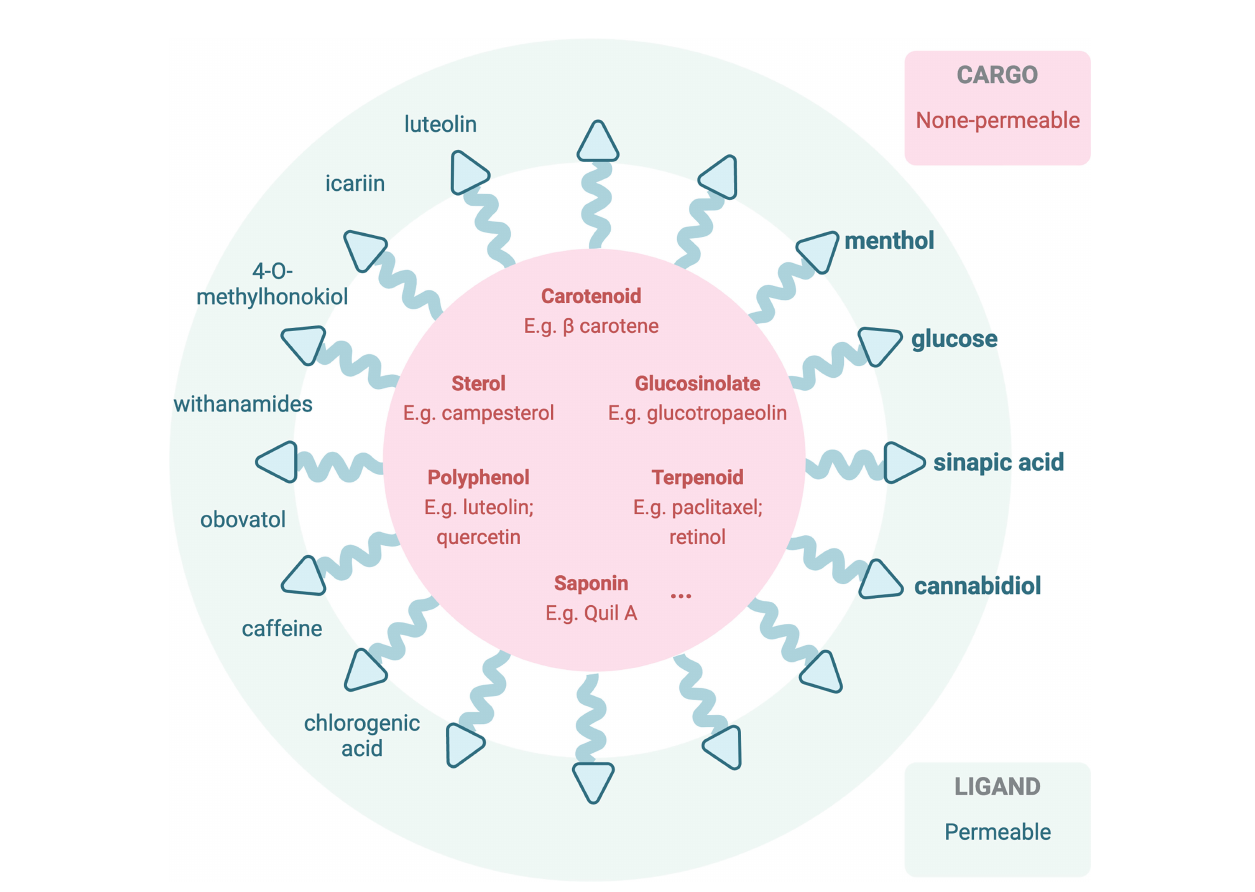
FIGURE 3 | Illustration of current or potentially applicable nanoparticles loaded with therapeutic active phytochemicals (impermeable to the BBB) (90, 91) or decorated with BBB-permeable phytochemicals for in vivo brain therapeutic uses. Bolded phytochemicals are ones that have been reported in previous studies based on PubMed database (92 –